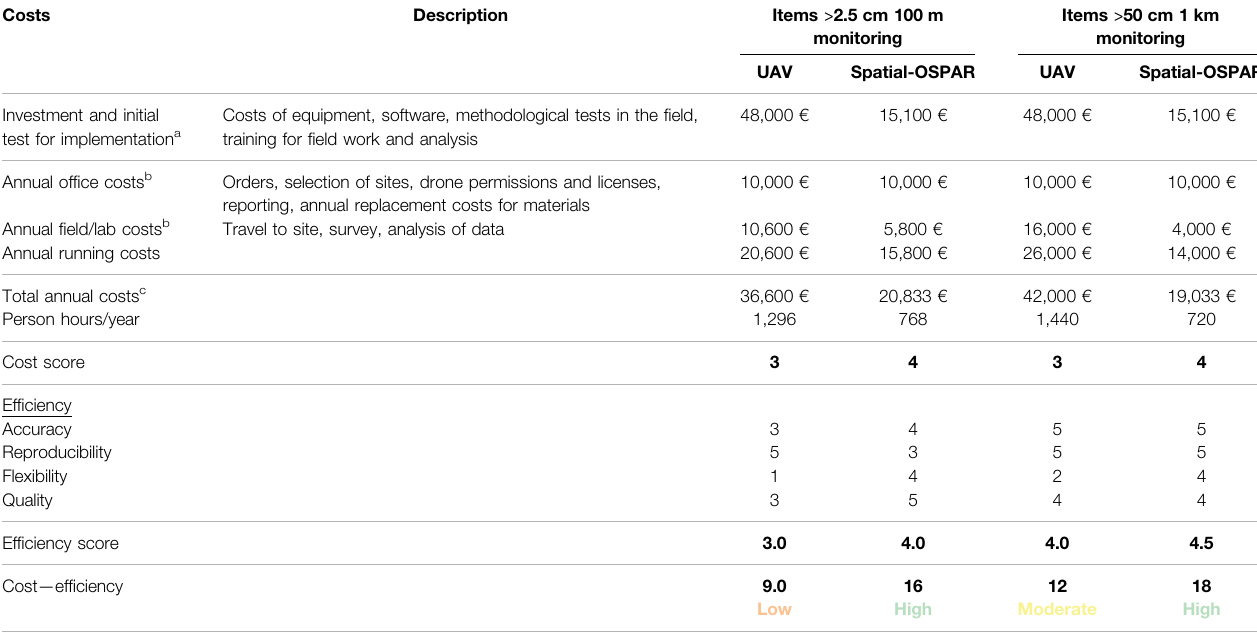
TABLE 3 | Cost-ef fi ciency analysis for UAV and spatial-OSPAR for beach litter monitoring methods. The values are based on our experience taking into account the MSFD guidelines (JRC, 2013) and federal state authority staff salaries (37.5 € perhour) for amonitoring offour beaches, fourtimes ayear. In bold areshown thescoresforcost and ef fi ciency, giving the cost-ef fi ciency